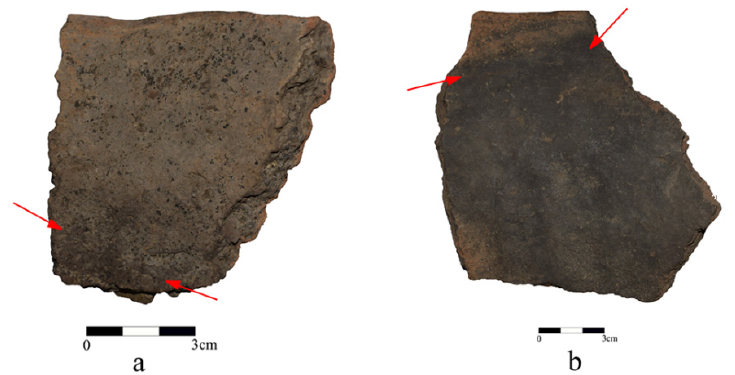
Figure 3. Storage vessels with traces of smudging ( a ) L6, ( b ) L7.